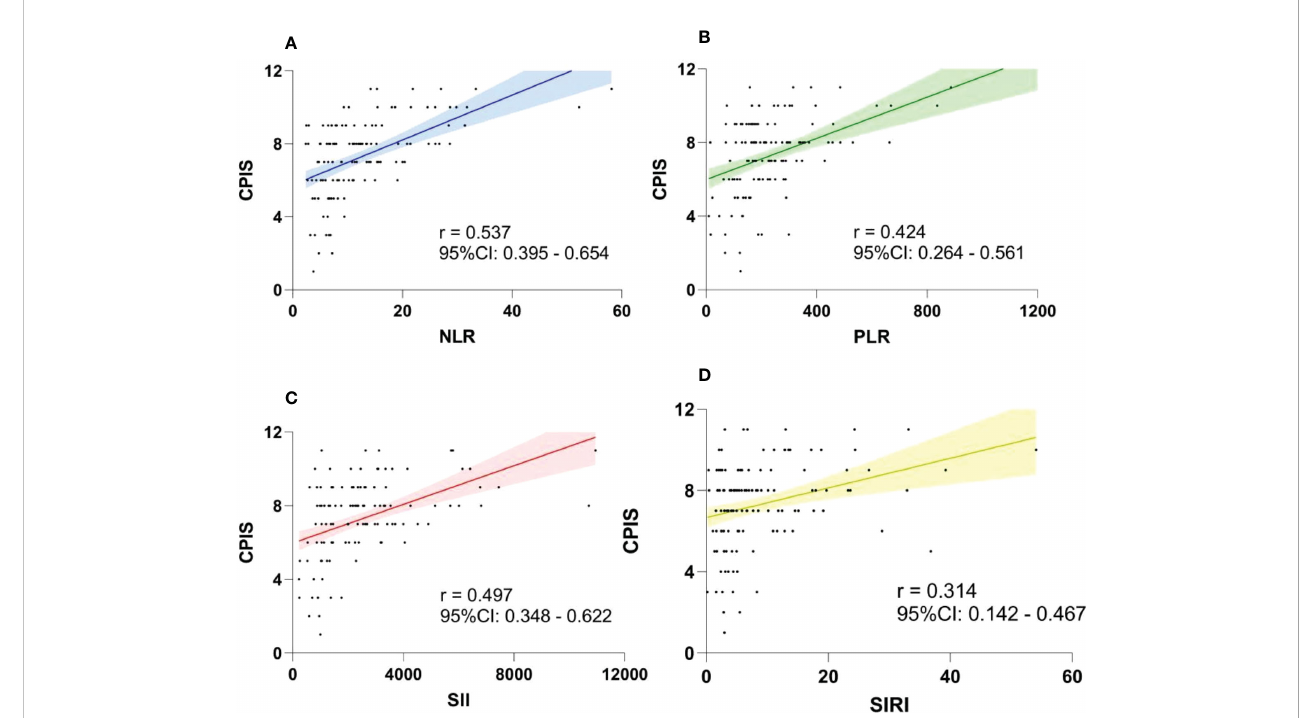
FIGURE 3 Association between the CPIS and NLR (A) , PLR (B) , SII (C) and SIRI (D) using Spearman ’ s analysis. The NLR had the highest correlation coef fi cient. CPIS, clinical pulmonary infection score; CI, con fi dence interval; NLR, neutrophil-to-lymphocyte ratio; SII, systemic immune-in fl ammation index; PLR, platelet- to-lymphocyte ratio; SIRI, systemic in fl ammation response index.